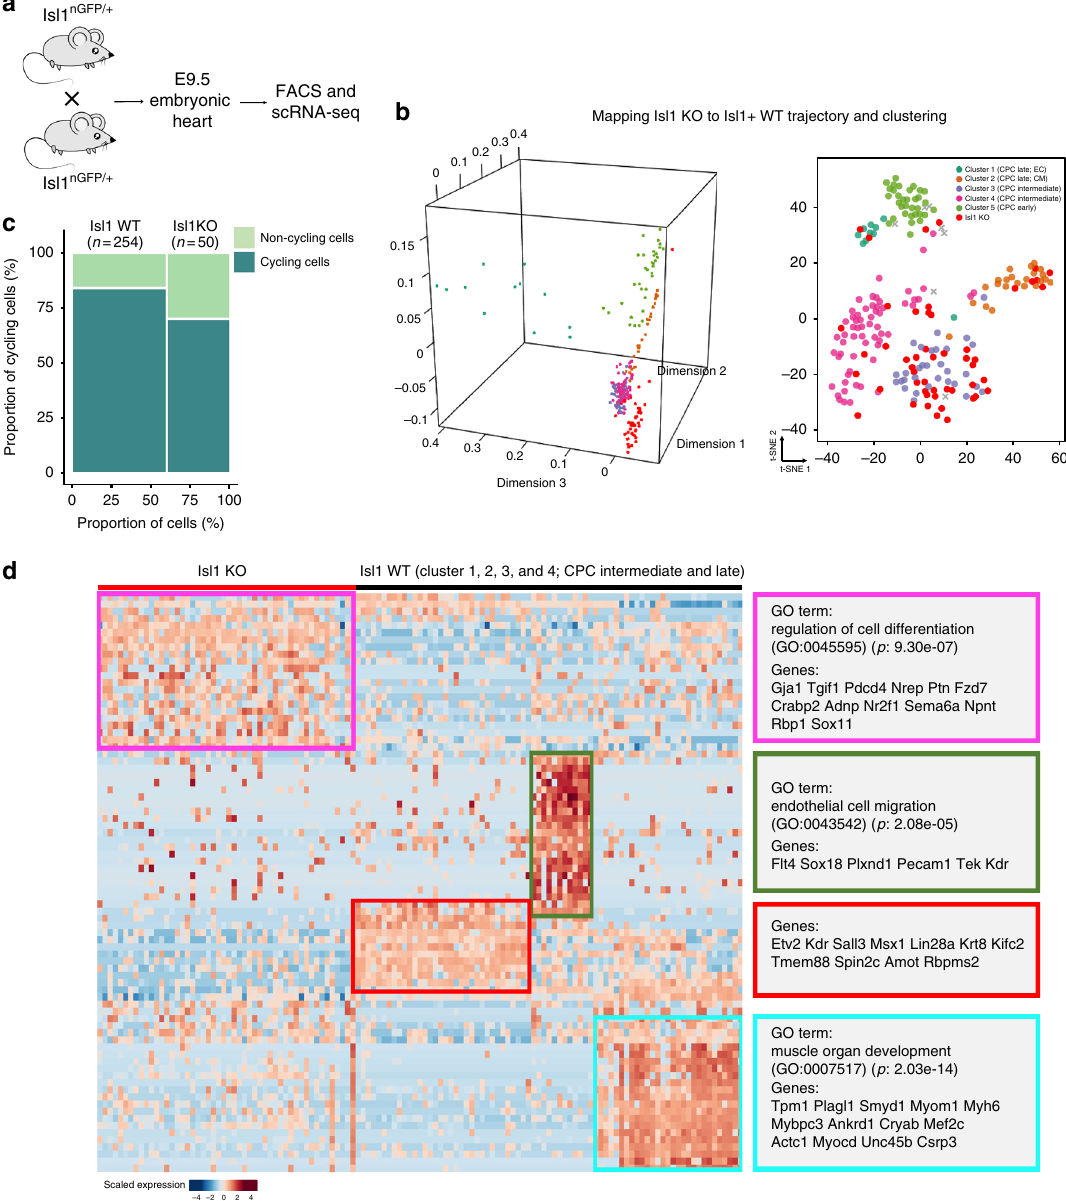
Fig. 5 Inactivation of Isl1 prevents CPC fate bifurcation. a Schematic illustration depicting generation of Isl1 embryos and scRNA-seq. b t-SNE plots showing the predicted diffusion pseudotime of Isl1 knockout CPCs projected on Isl1 + cells (left), and clustering with Isl1 + cells (right). c Ratios of cycling and non- cycling Isl1 knockout and wild type Isl1 + CPCs. χ 2 test: p = 0.062. n indicates cells numbers. d Heatmap showing expression of deregulated genes in Isl1 + cells at E8.5 and E9.5 (cluster 1, 2, and 5) isolated from Isl1 knockout and control embryos. Source data are provided in the Source Data fi